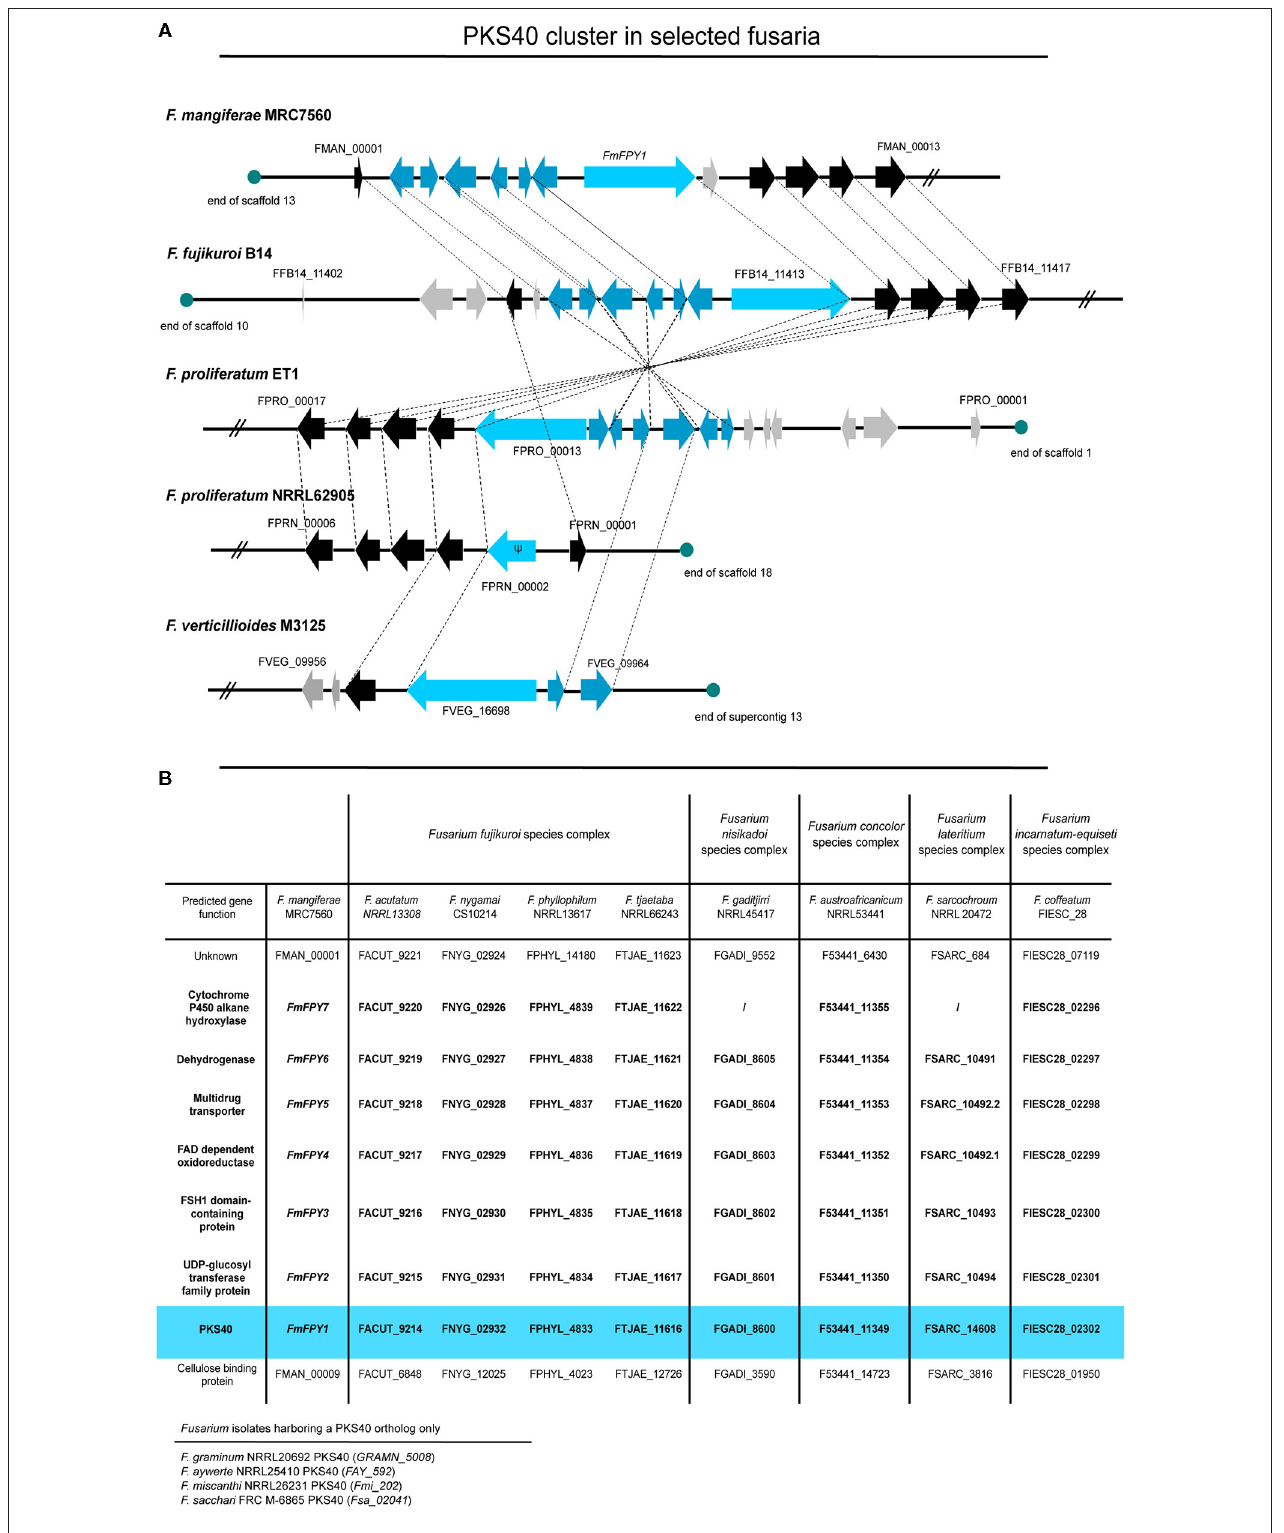
FIGURE 9 | Comparison of PKS40 cluster in different members of the FFSC. (A) The putative PKS40 gene cluster is only present in F. mangiferae MRC7560 , F. fujikuroi B14, and F. proliferatum ET1. For F. proliferatum NRRL62905 only a remnant of PKS40 and no other putative cluster genes are present, while for F. verticillioides M3125 an orthologous PKS40 gene and only two cluster genes can be found. Light blue arrows indicate the respective PKS40 key enzyme, while blue